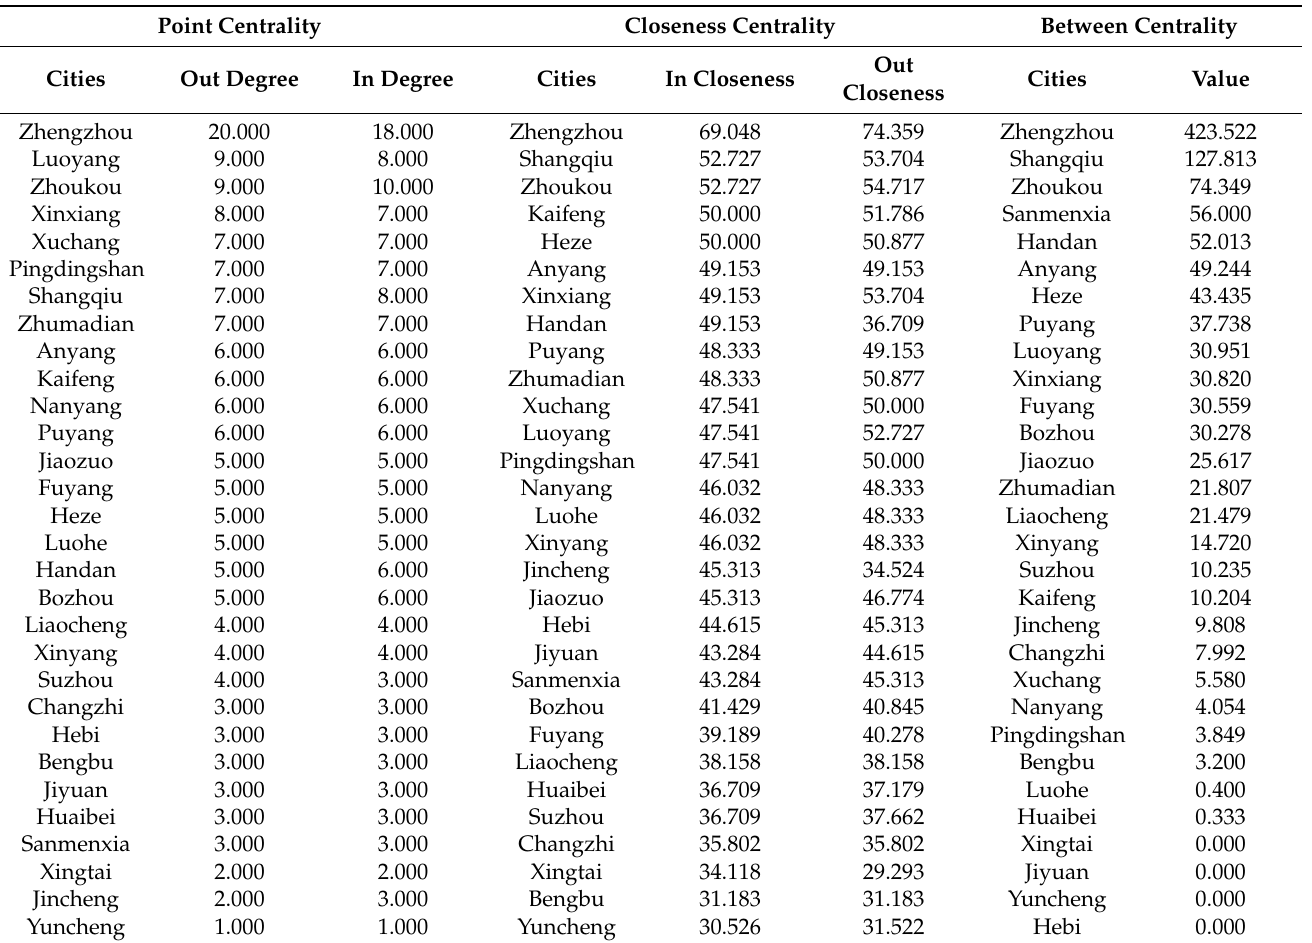
Table 1. Network centrality of Zhongyuan Urban